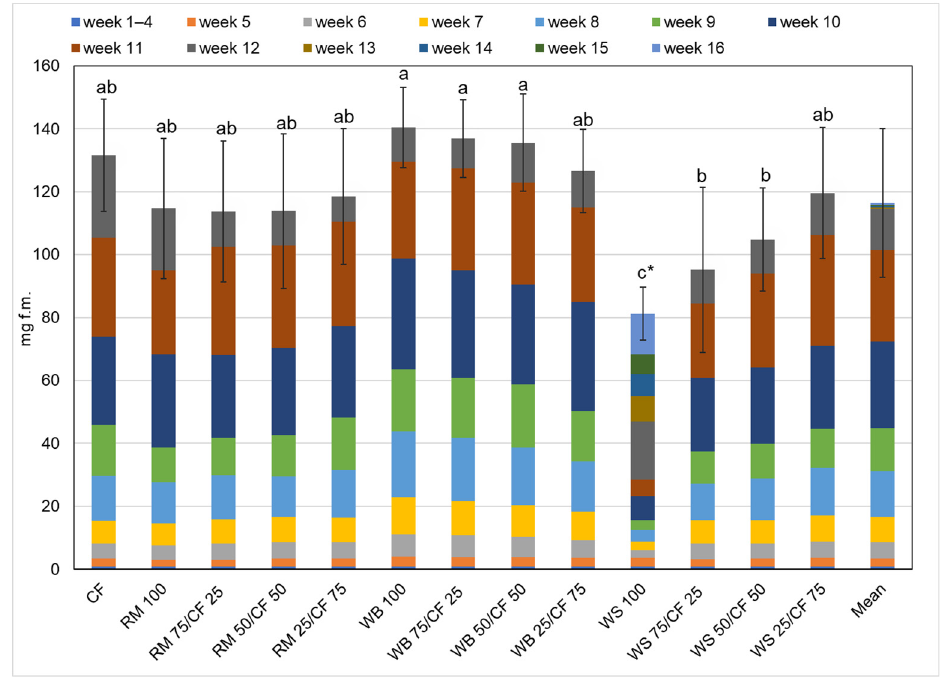
Figure 1. Individual fresh weight of yellow mealworm larvae depending on the week and the experimental diet. a,b,c…—letters indicate that values are statistically different (Tukey’s test at p < 0.05), (* the mean of 2 trials).